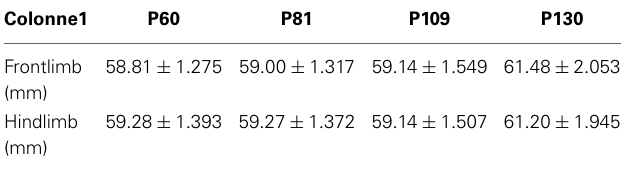
Table A1 | Frontlimb and hindlimb stride (mm) of control mice at P60 ( n = 22), Control NaCl at P81 ( n = 12), P109 ( n = 13) and P130 ( n =